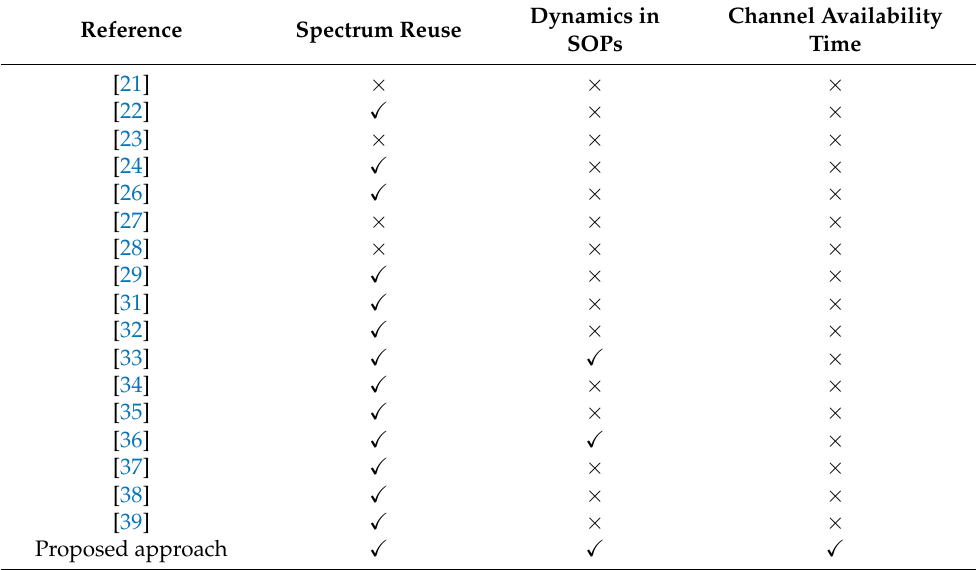
Table 1. Literature study on auction models used for spectrum allocation in cognitive radio net- works